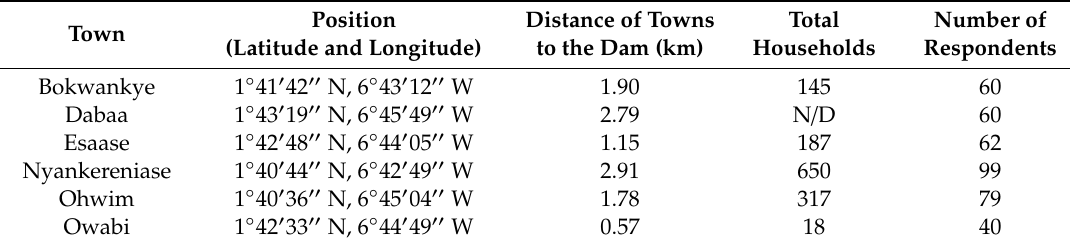
Table 1. Characteristics of the study communities.